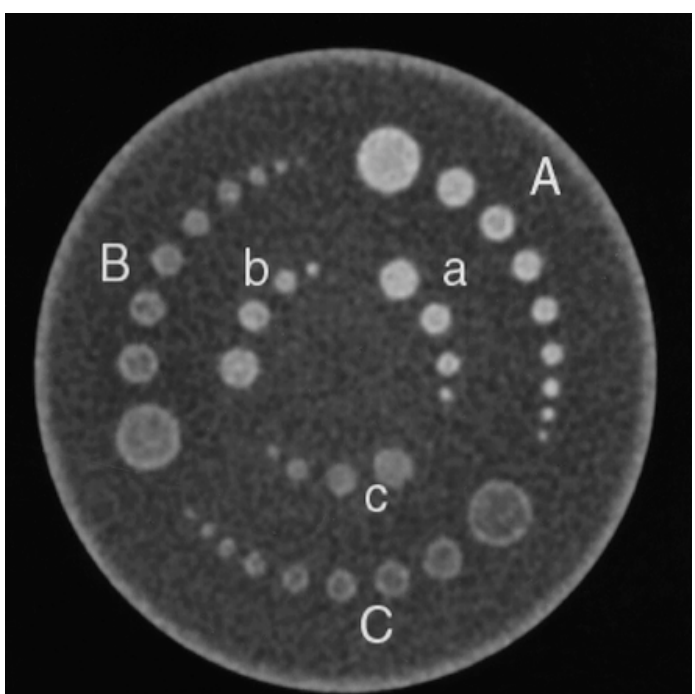
Figure 1. A Phantom of low contrast module. Six different regions have been depicted where low contrast objects are put (A–C and a–c). Low cylindrical objects were placed in Regions A–C to contrast the difference in the objects in Regions A/a, B/b and C/c with the backgrounds of 1%, 0.5% and 0.3%, respectively.